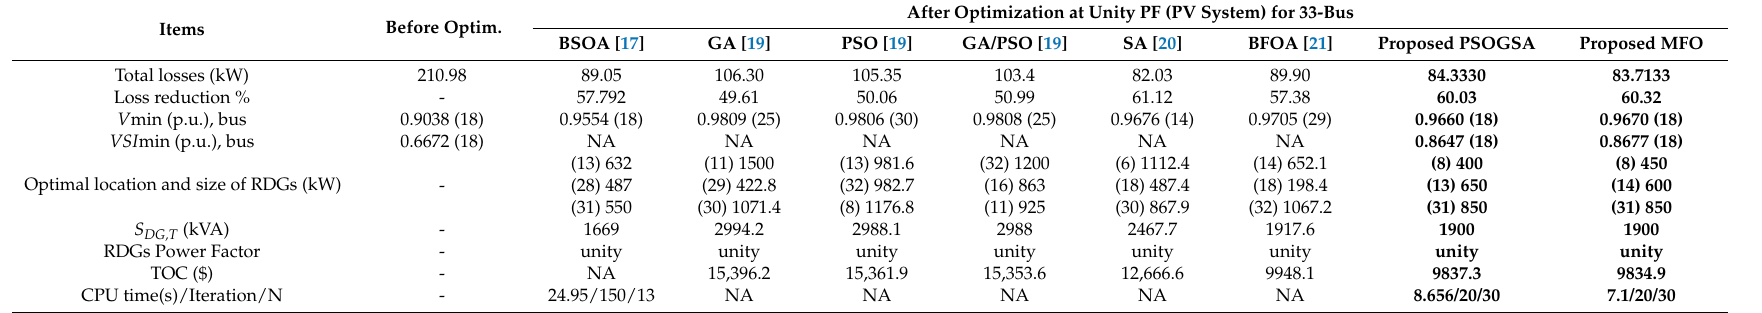
Table 3. The results of 33-bus IEEE distribution network at unity PF (PV type).